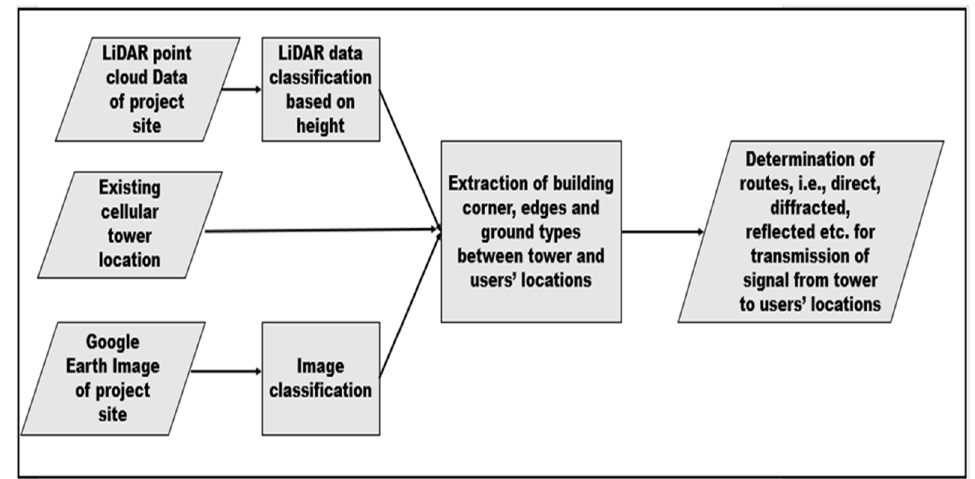
Figure 5. Terrain parameter determination between tower and users’ locations.